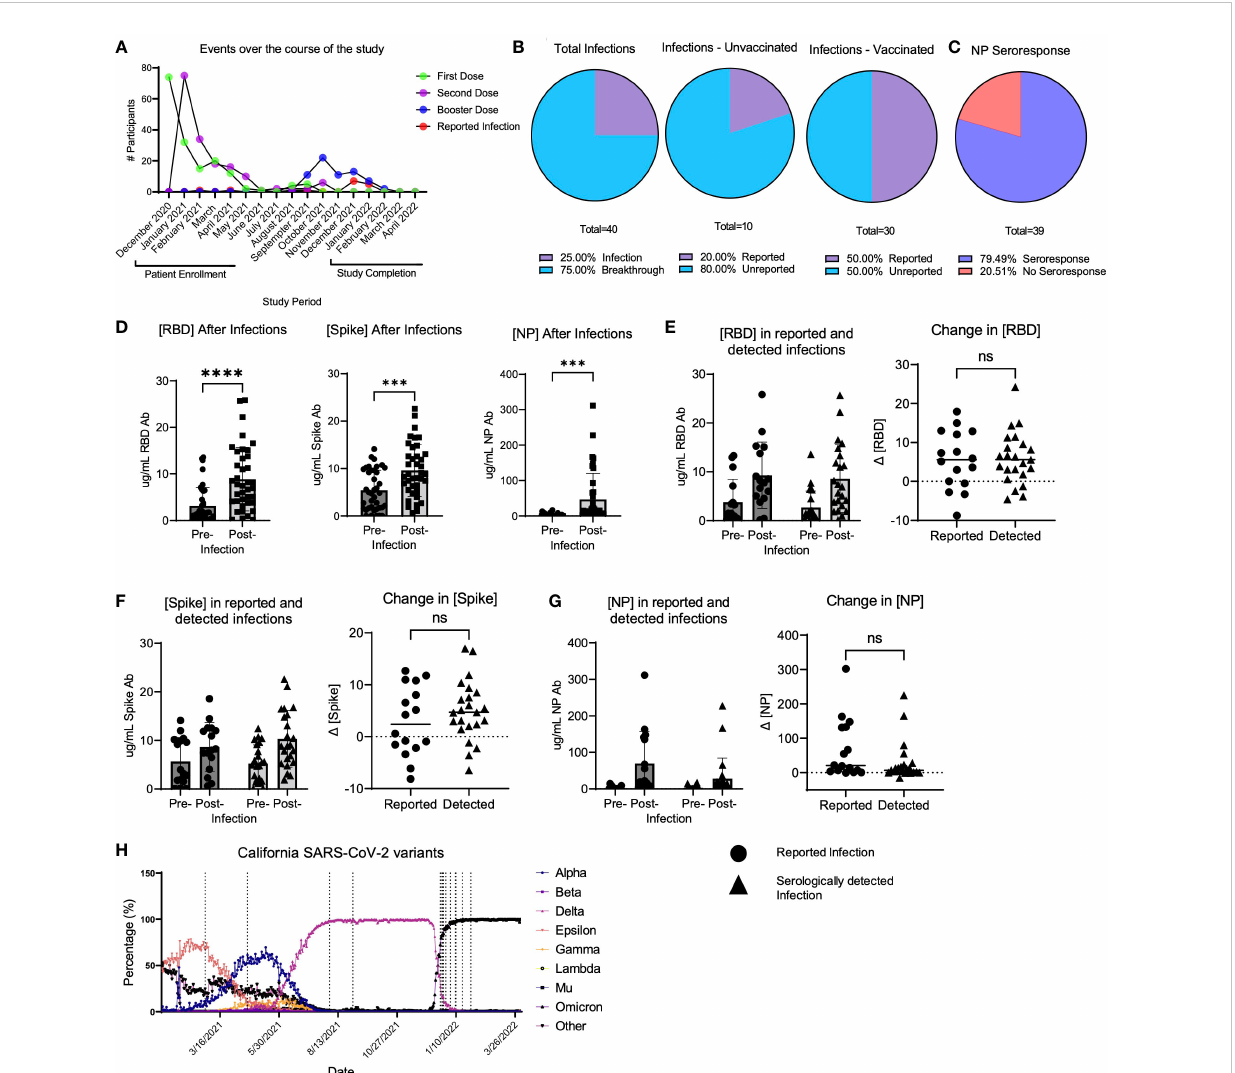
FIGURE 1 LA-SPARTA infections during the study period. (A) shows the events that occurred for all LA-SPARTA participants over the course of the study period. (B) describes both the reported and serologically detected infections in unvaccinated participants and breakthrough infections in vaccinated participants. (C) shows the percentage of infections and breakthrough infections in which the NP concentration increases by ≥ 4-fold compared to the previous blood sample collected. (D) shows the concentration of RBD, Spike, and NP in all serologically detected and reported infections and breakthrough infections. (E) shows the concentration of RBD in infections and breakthrough infections, separated by serologically detected versus reported infections. The delta change between the pre-infection sample collected and post-infection samples is also shown. (F) shows the concentration of Spike in infections and breakthrough infections, separated by serologically detected versus reported infections. The delta change between the pre-infection sample collected and post-infection samples is also shown. (G) shows the concentration of NP in infections and breakthrough infections, separated by serologically detected versus reported infections. The delta change between the pre-infection sample collected and post-infection samples is also shown. (H) uses SARS-CoV-2 variant data available from the California department of Health and Human Services from Los Angeles County to illustrate the percentage of each variant circulating at the time of reported positive tests (vertical dashed lines) in the LA-SPARTA cohort. *** designates P >0.001 and **** designates P >0.0001. ns, not signi fi